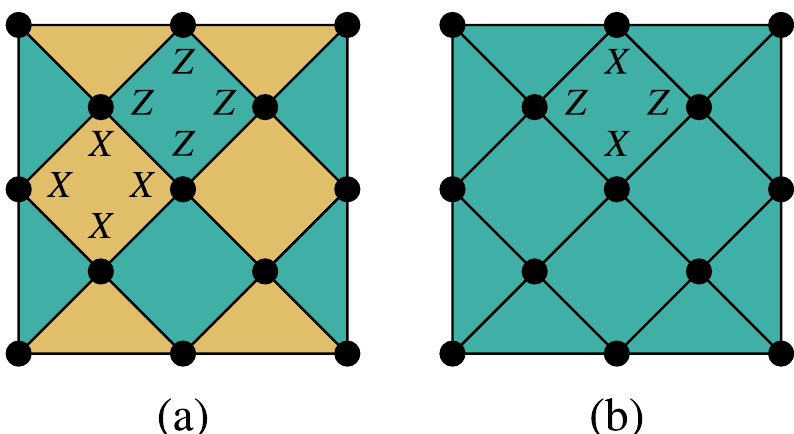
Fig. 1 Examples of surface codes. a The standard surface code has alternating plaquettes with X and Z stabilizers. b The XZZX surface code has the same stabilizer on every plaquette, the product of two X and two Z operators. The XZZX surface code can be obtained from the standard surface code via local Pauli frame